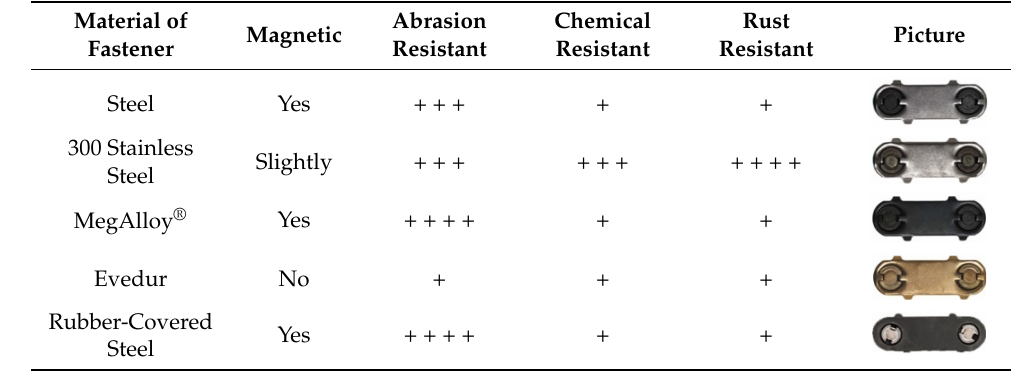
Chemical Resistant